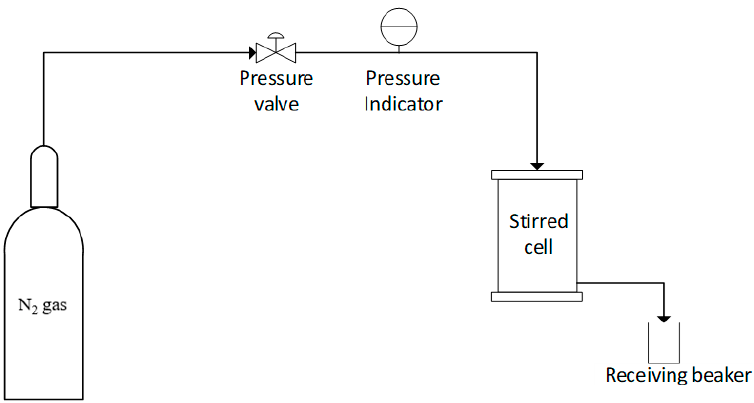
Figure 1. UF stirred cell test rig.